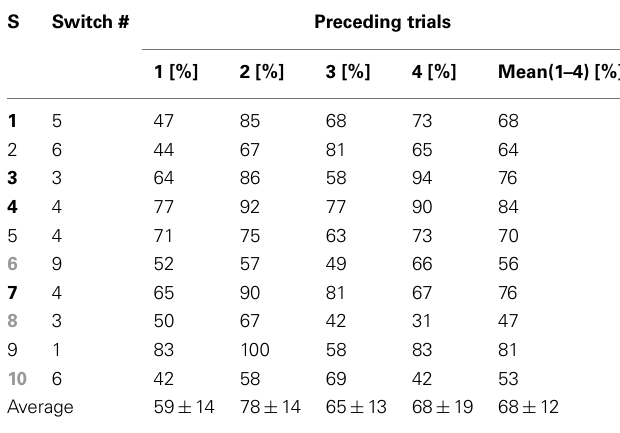
Table 4 | Number of BCI → JS switches and performances at respective points in